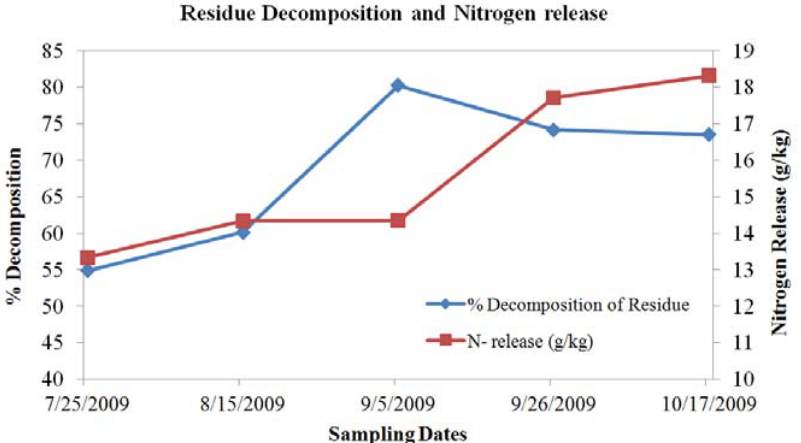
Figure 1. Graphical representation of cover crop residue decomposition at different sampling